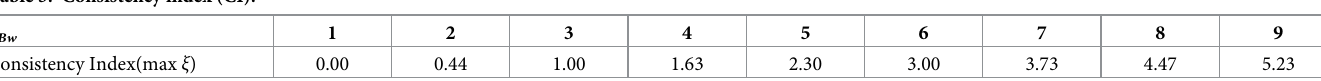
Table 3. Consistency index